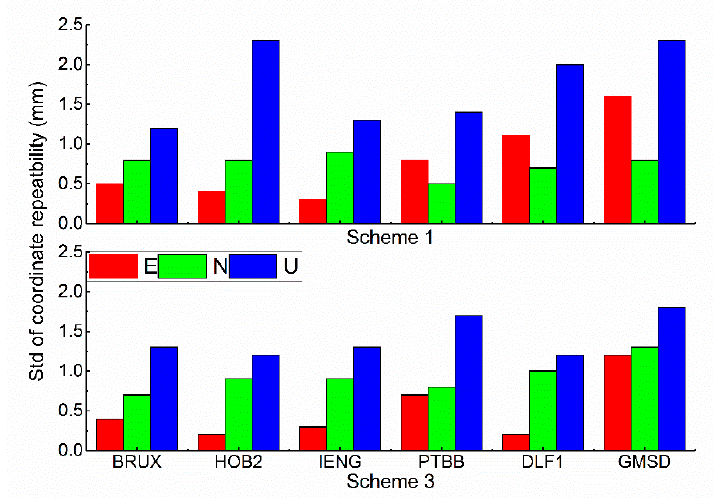
Figure 5. The standard deviation of coordinate repeatability for the six stations.